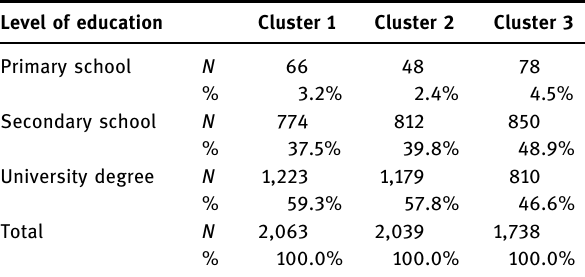
Table 10: Association between level of education and